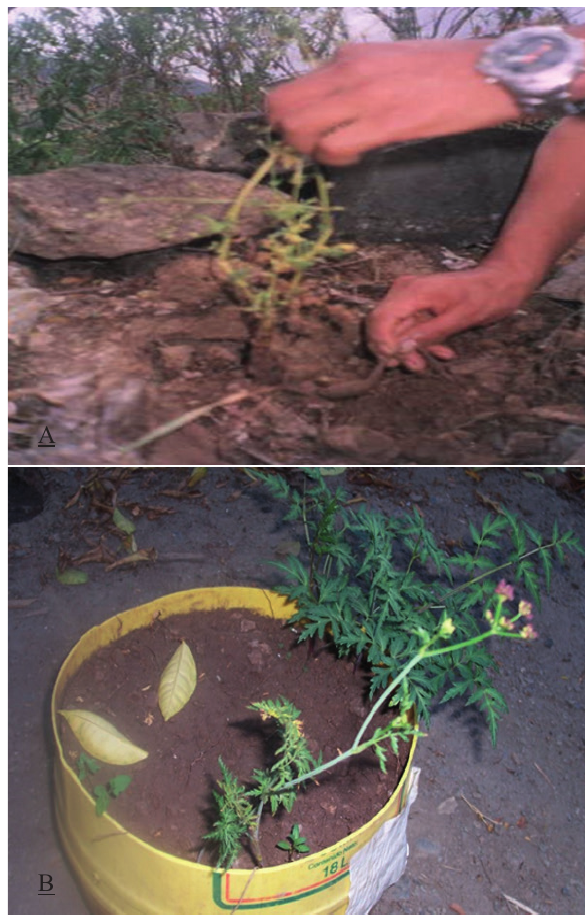
Figure 5. Wild arracacha arracacha, grandfather arracacha of tempera in their natural habitat ( A. incisa ) (A) and arracacha of puna grandfather reproduced in pot ( A. incisa ) (B).